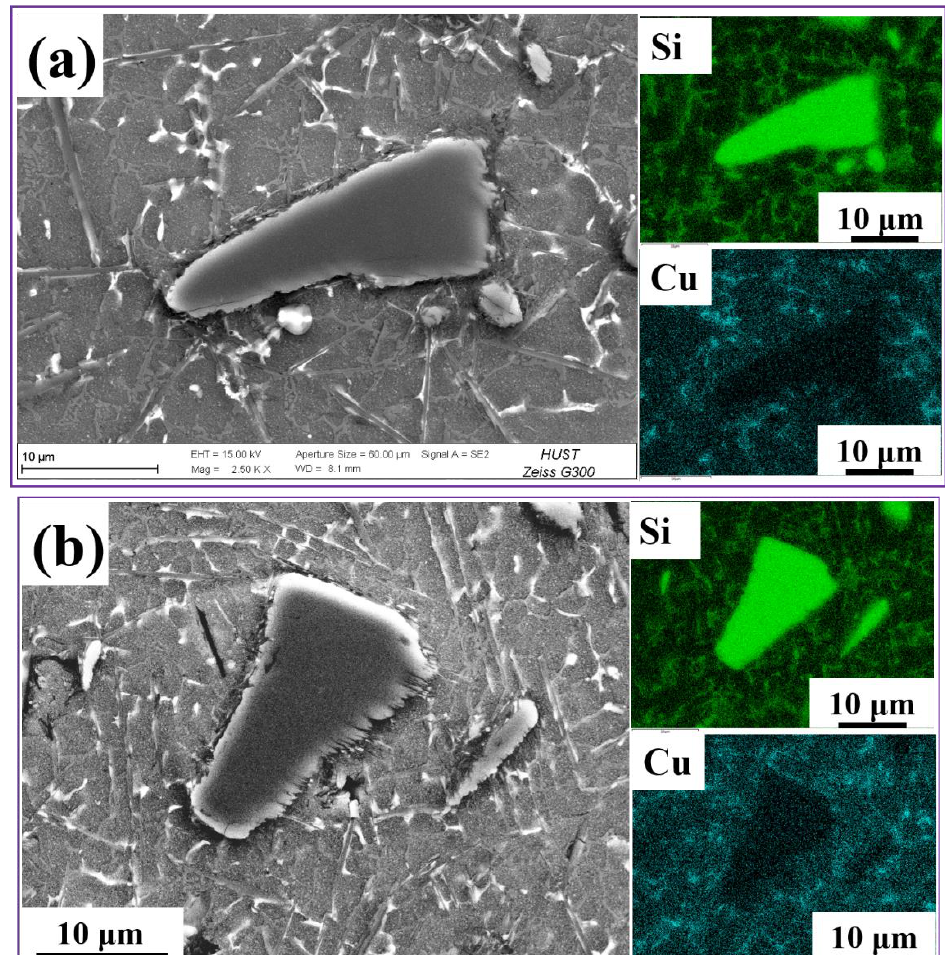
Figure 4. SEM image of SiC in the fusion zone. ( a ) Representative sample Y1; ( b ) Representative sample Y2.